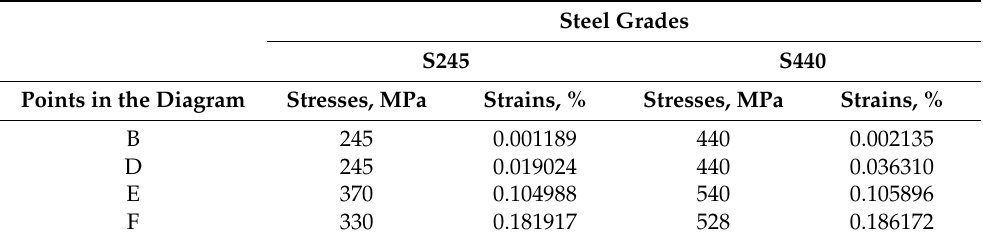
Table 2. Parameters of the steel behaviour